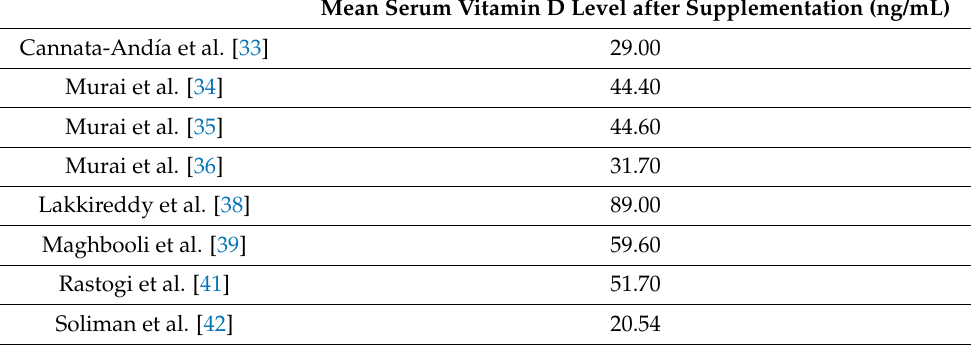
Table 3. Mean plasma vitamin D level after supplementation in the intervention group.